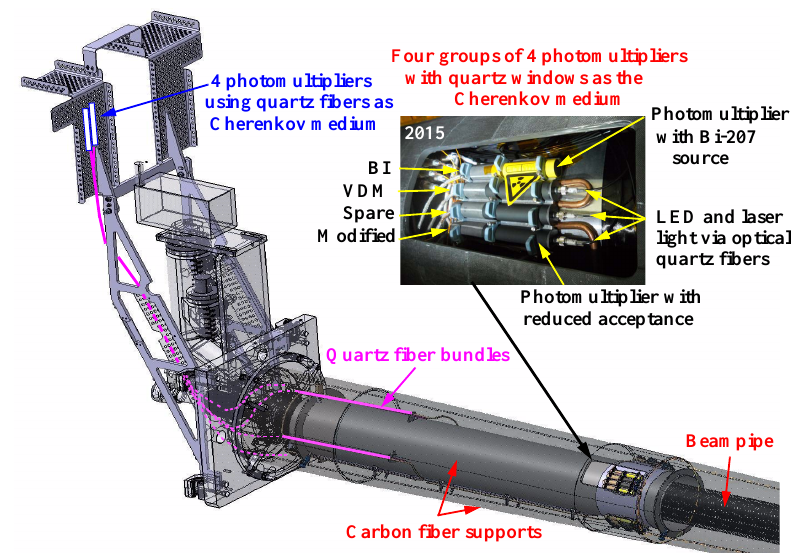
Figure 1. Schematics of one of the modules of the LUCID-2 detector. The inset shows the setup in 2015, including photomultipliers (PMTs) calibrated via LED (Light-Emitting Diode) or laser light (labelled as VDM in the picture since initially thought to be best for Van Der Meer scans), recently replaced by PMTs equipped with 207 Bi radioactive sources [5]. The centers of the photomultipliers are 125 mm from the beam